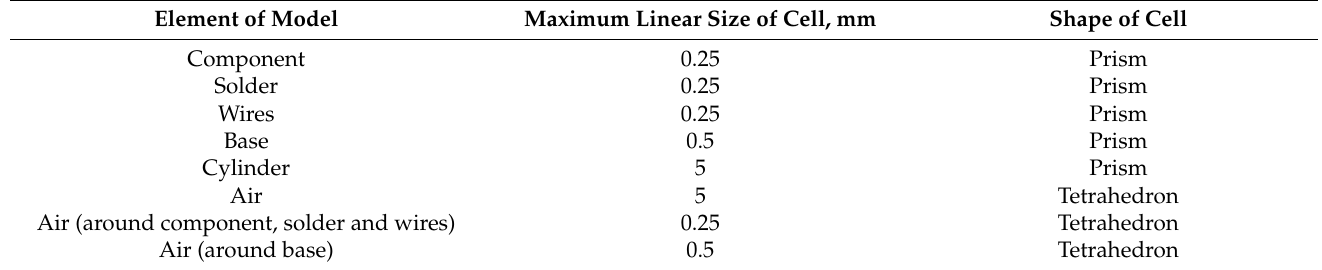
Figure 5. The cross-section of the grid created on the geometric model: 1—component; 2—base; 3—solder; 4—wire; 5—the air around the component, solder and wires; 6—the air around the base; 7—air.